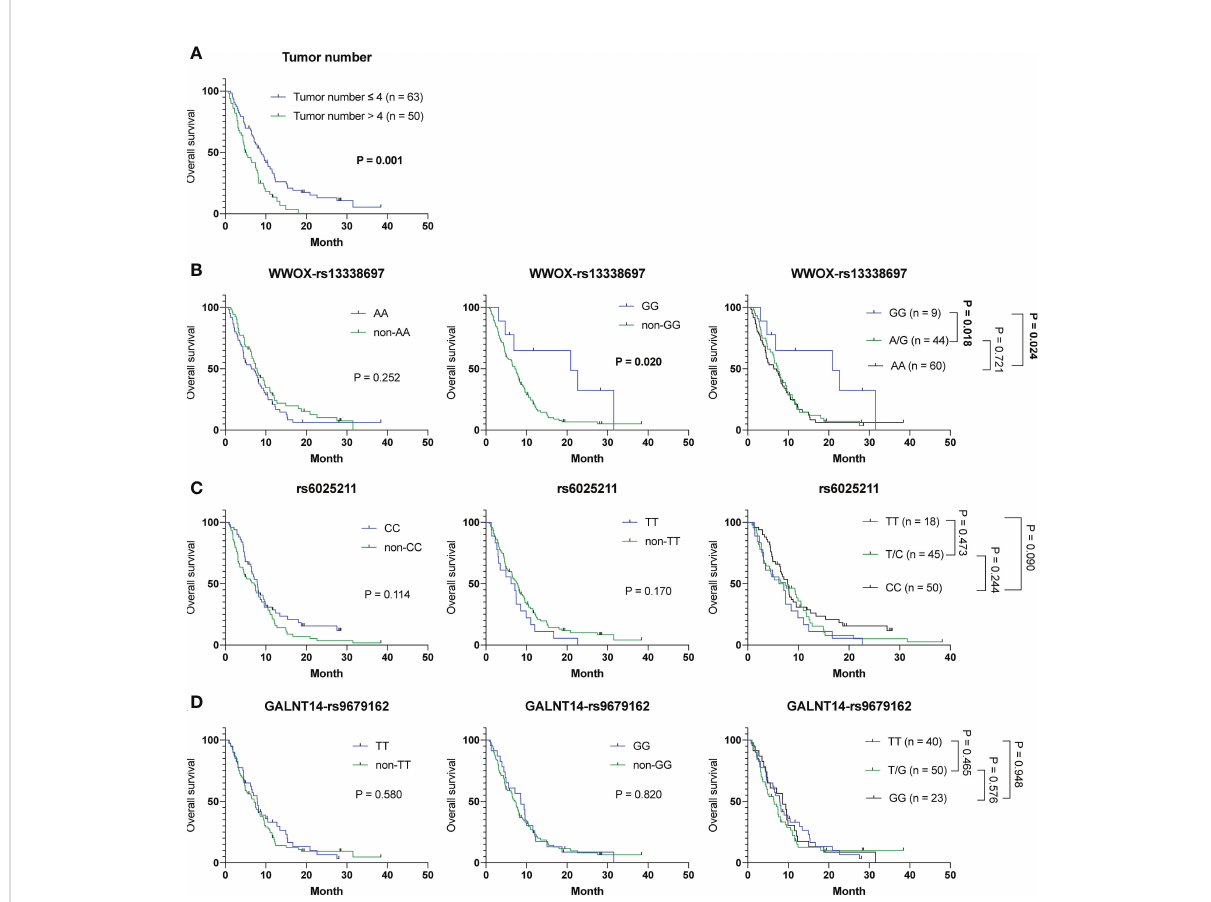
FIGURE 1 Analysis of clinicopathological factors and SNP genotypes in association with OS in HCC patients treated with ADI-PEG 20 monotherapy. Kaplan-Meier analysis for subgroups of patients with HCC strati fi ed by (A) tumor number, (B) WWOX -rs13338697, (C) rs6025211, and (D) GALNT14 -rs9679162 genotypes. P values were obtained by log-rank test, and < 0.05 was considered signi fi